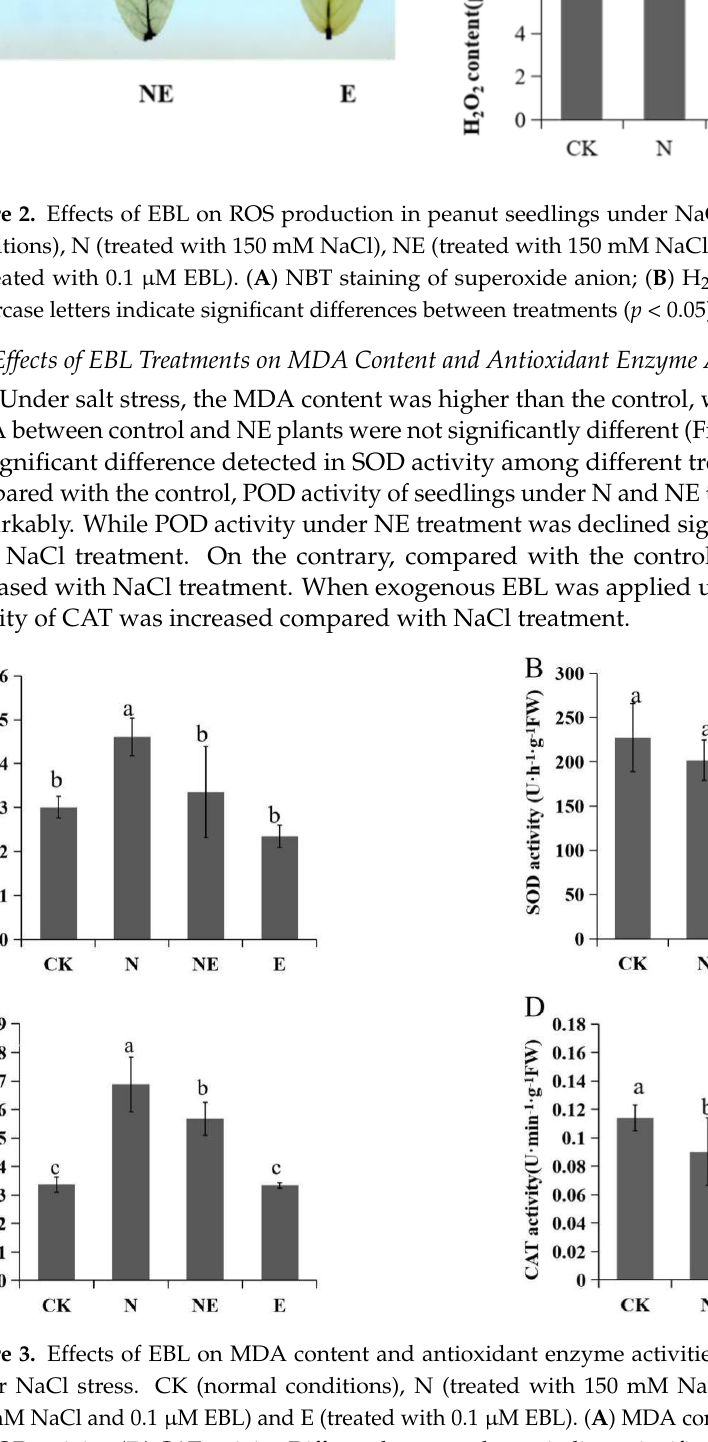
Figure 3. Effects of EBL on MDA content and antioxidant enzyme activities of peanut seedlings under NaCl stress. CK (normal conditions), N (treated with 150 mM NaCl), NE (treated with 150 mM NaCl and 0.1 µM EBL) and E (treated with 0.1 µM EBL). ( A ) MDA content; ( B ) SOD activity;